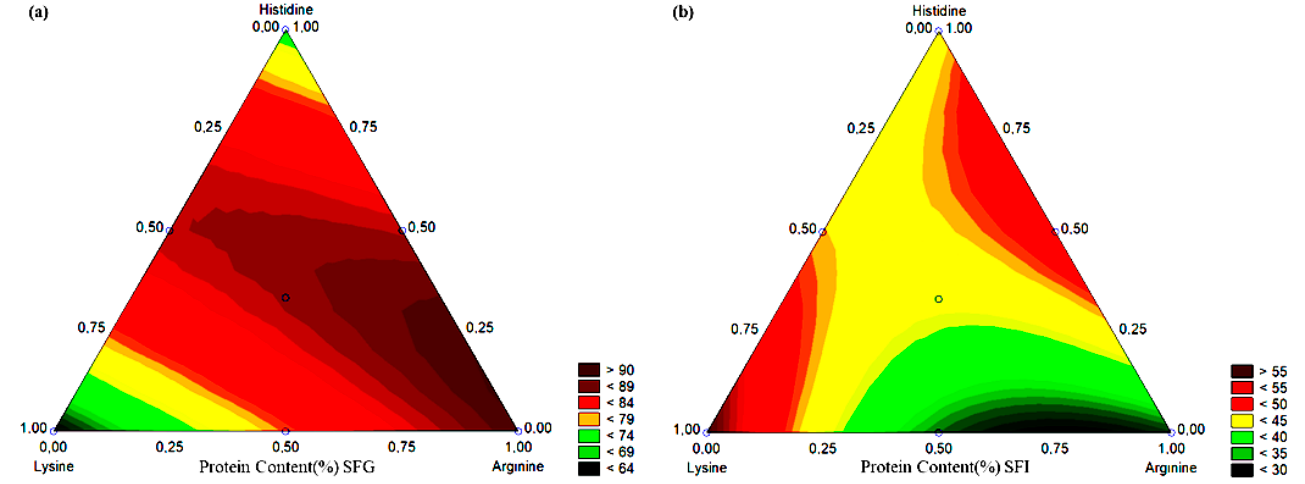
Figure 1. Contour curve of the tested systems for protein content (%) in (a) SFG and (b) SFI.